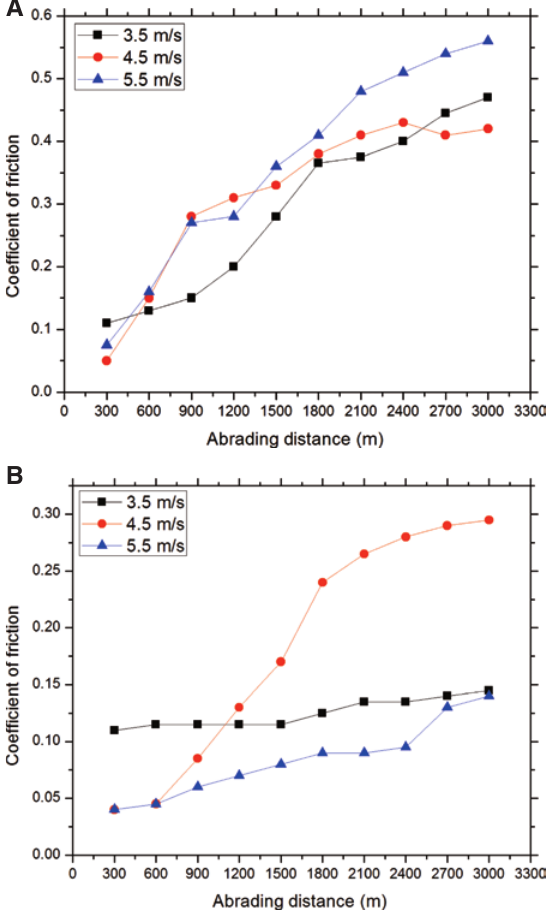
Figure 10 Worn surface morphology, run at 5.5 m s -1 with 20 N load: untreated composites (A) and alkali-treated composites (B).